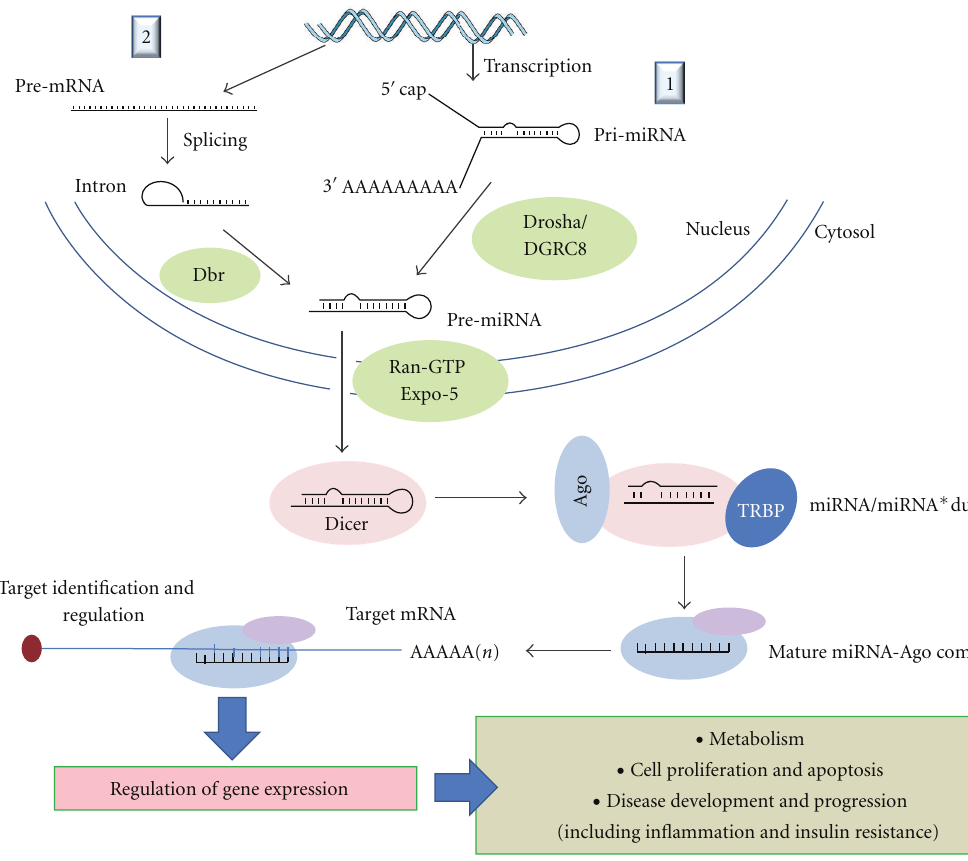
Figure 4: MicroRNA (miRNA) biogenesis and gene expression control in human cells. (1) Canonical pathway produces pre-miRNA by Drosha/DGCR8 cleavage of pri-miRNA. (2) Noncanonical pathway mirtrons are produced by spliced introns debranched by debranching enzyme (Dbr), after which they fold into pre-miRNA hairpins. Pre-miRNA hairpins are exported from the nucleus to cytosol by exportin-5 (Expo-5) and cleaved by Dicer to produce 22 nucleotides RNA duplexes. One strand of the duplex is transferred to Argonaute complex (Ago) and guided to base-pair with its target mRNA throughout its seed sequence. TRBP: tar-RNA binding